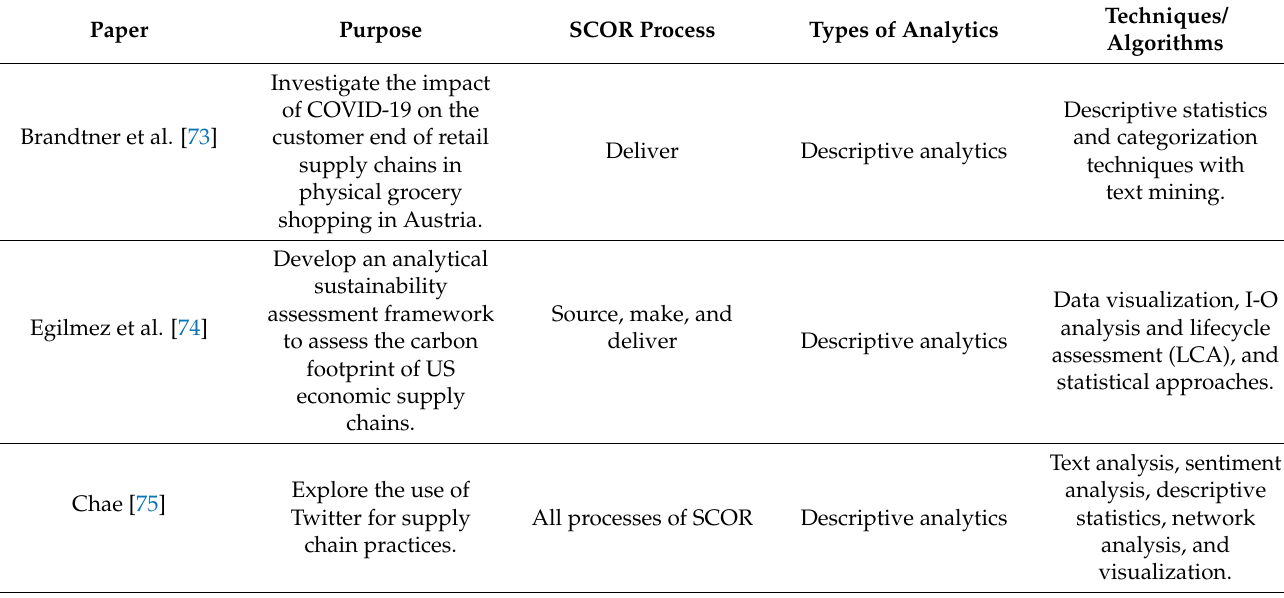
Table 7. Paper, purpose, SCOR processes, types of BDA, and techniques/algorithms of